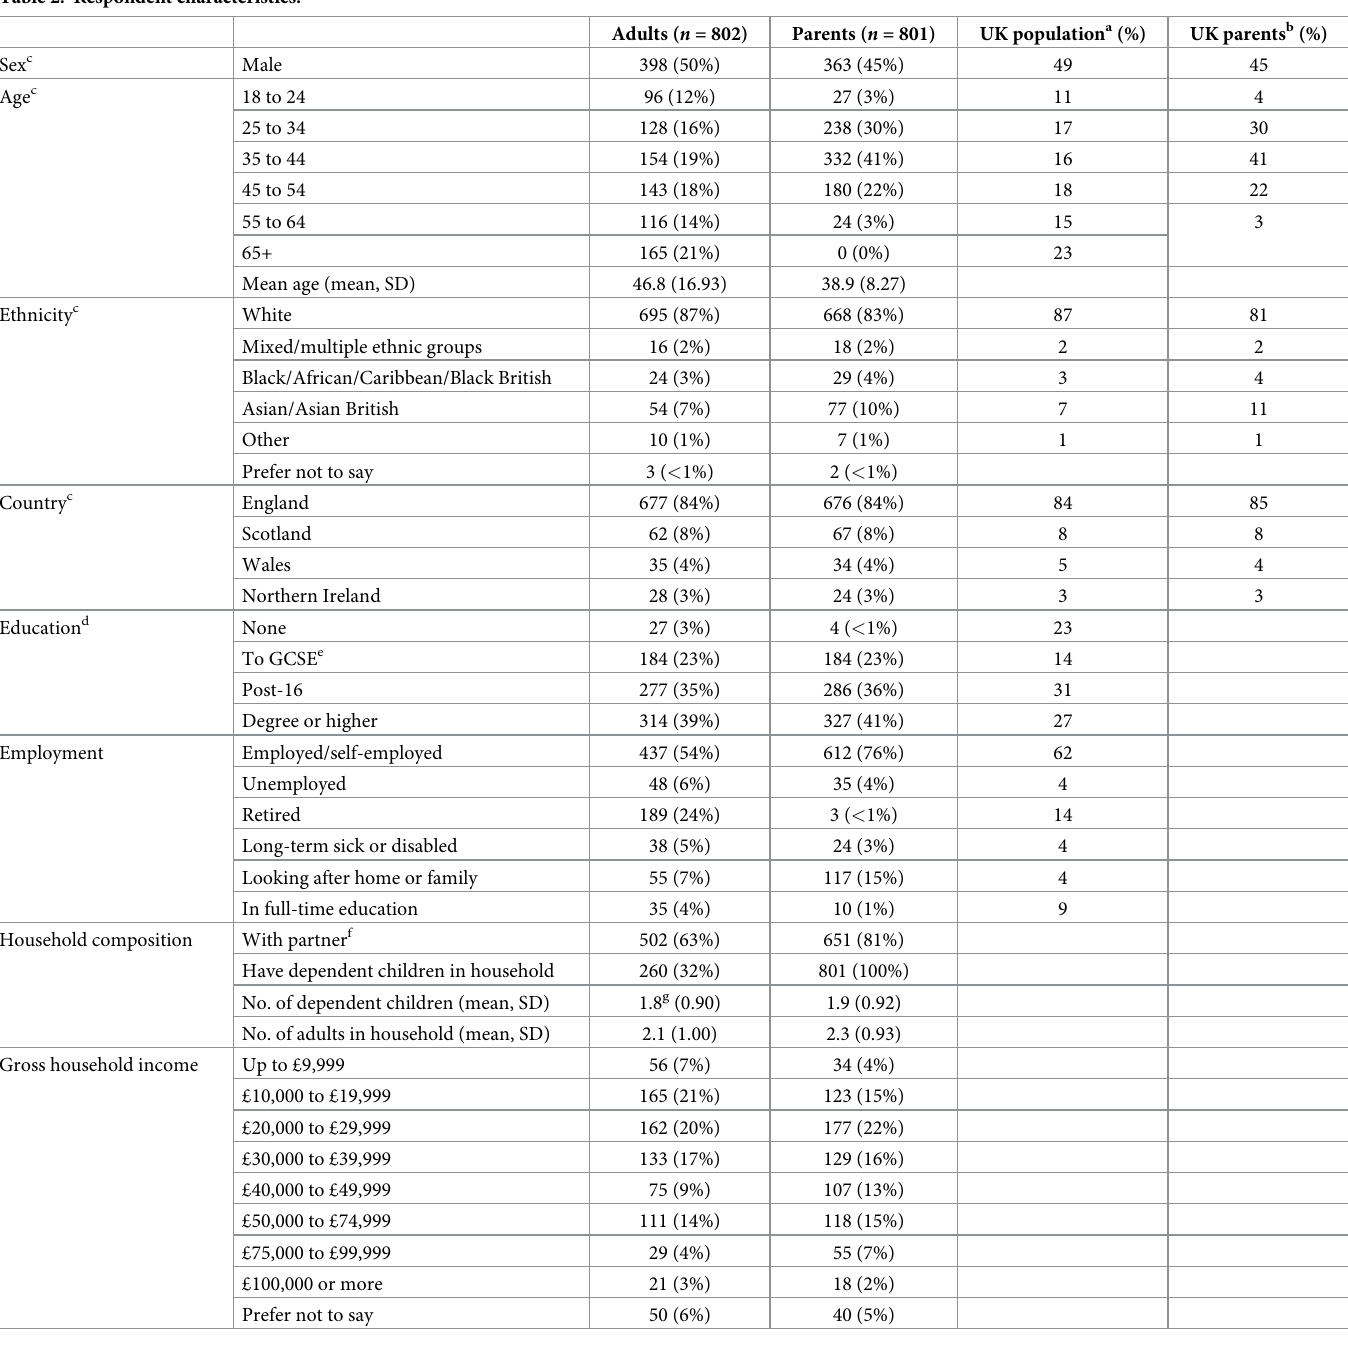
Table 2. Respondent